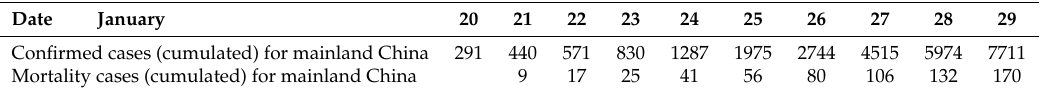
Table 2. Reported case data 20–29 January 2020, reported for mainland China by the Chinese CDC [1].